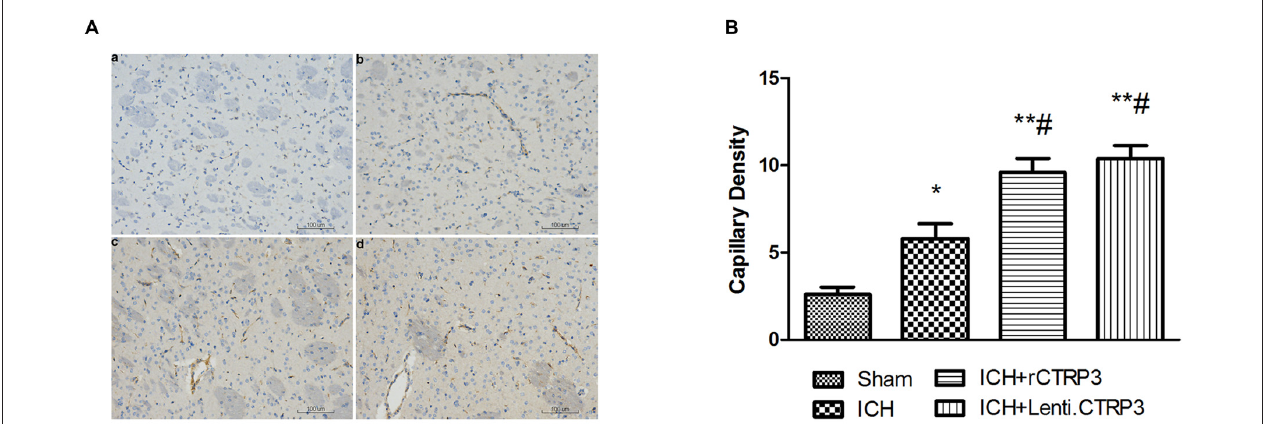
FIGURE 4 | CTRP3 encourages angiogenesis in the hematoma border zone 7 days after ICH. (A) Capillary density computed by immunohistochemical staining for CD31 (brown) in the perifocal region in ICH (b) , rCTRP3 (c) and Lenti-CTRP3 (d) 7 days after ICH. A control brain section demonstrates a normal distribution of microvessels in the same region (a) . Bar = 100 µ m. (B) Bar graph showing the number of brown stained capillaries 7 days after ICH. Values are mean ± SEM. n = 5 per group. ∗ p < 0.05 vs. sham; ∗∗ p < 0.01 vs. sham; # p < 0.05 vs. ICH. CTRP3, C1q/tumor necrosis factor-related protein-3; rCTRP3, recombinant CTRP3; Lenti-CTRP3, Lentivirus overexpression of CTRP3; ICH, intracerebral hemorrhage; CD31, platelet endothelial cell adhesion molecule-1.